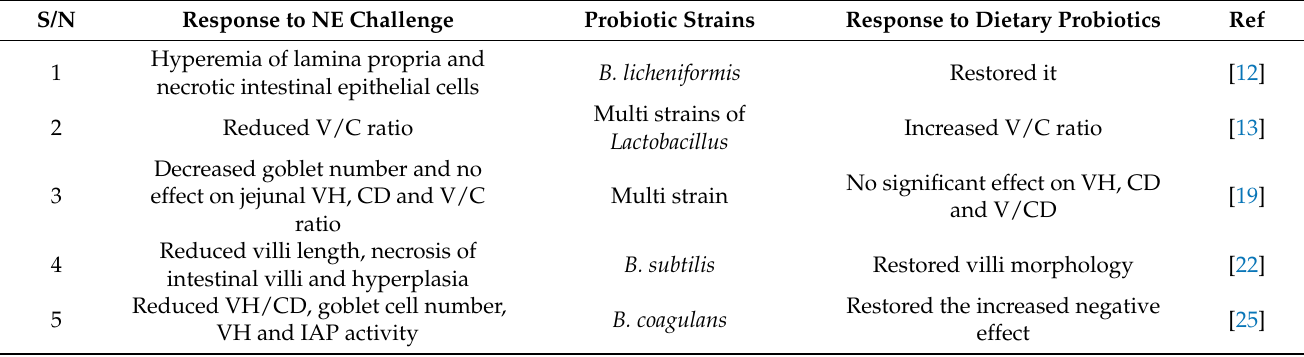
Table 4. Influence of NE challenge on intestinal villi morphology and the regulatory effects of